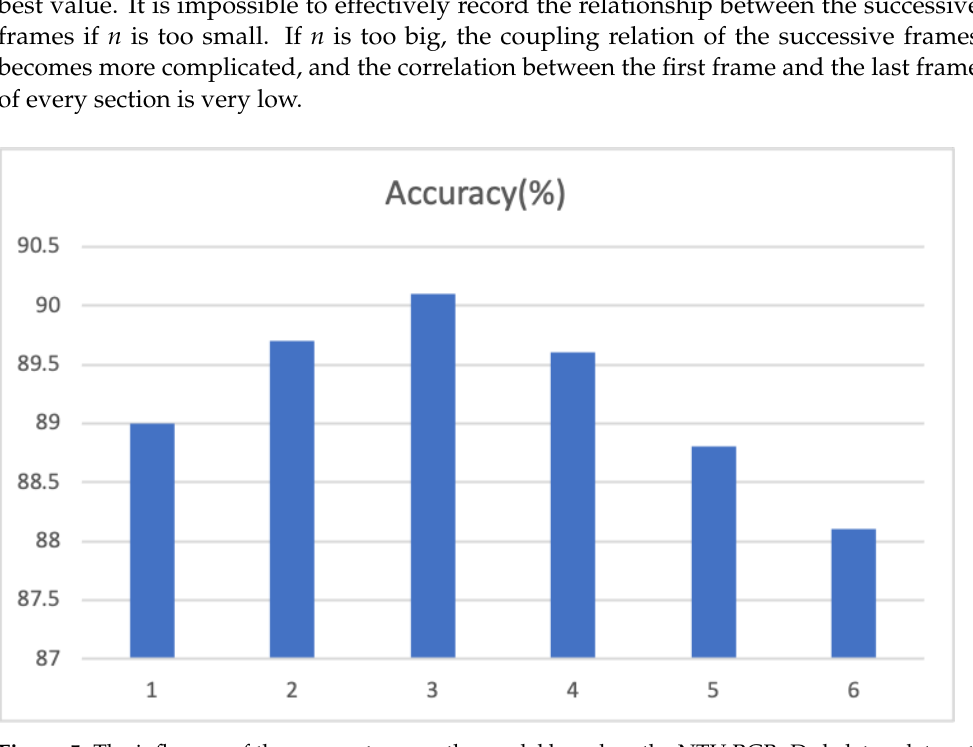
Figure 5. The influence of the parameter n on the model based on the NTU RGB+D skeleton data